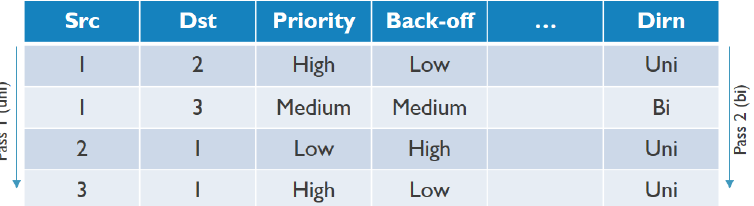
Figure 9. QoS table parsing